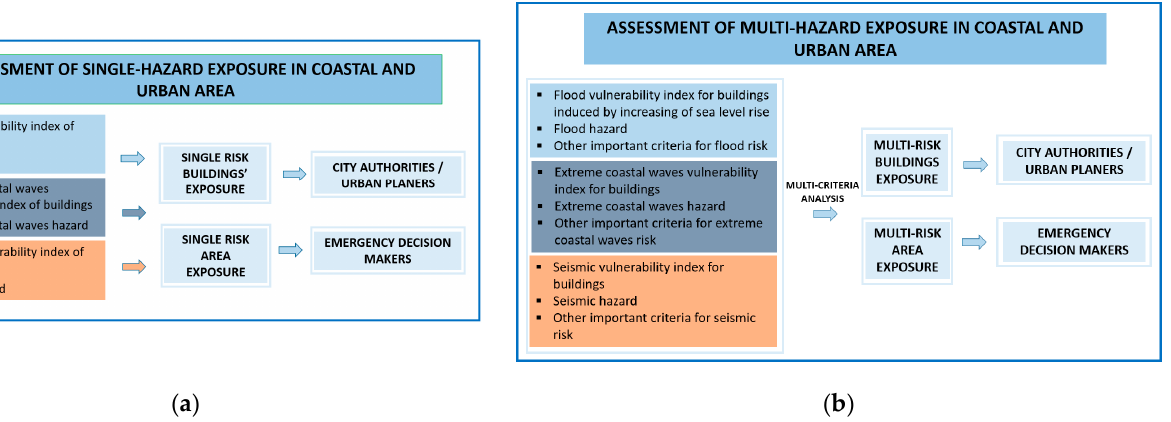
Figure 4. The scheme of the risk assessment for investigated area: ( a ) single-hazard exposure; ( b ) multi-hazard exposure.